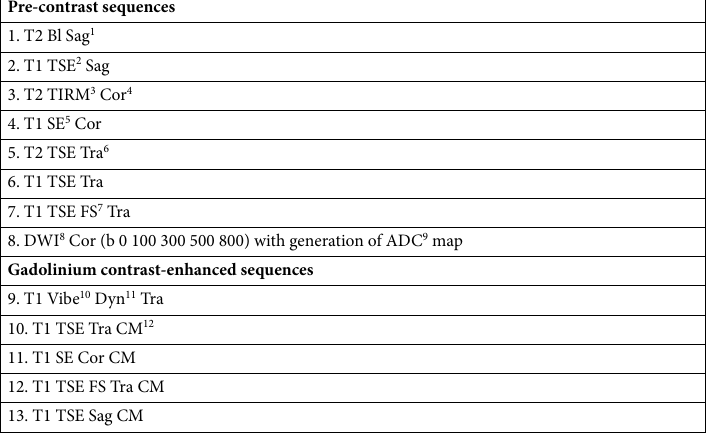
Table 1. MRI examination protocol. 1 Sag, sagittal; 2 TSE, Turbo Spin Echo; 3 TIRM, Turbo Inversion Recovery Magnitude; 4 Cor, coronal; 5 SE, Spin Echo; 6 Tra, transverse; 7 FS, Fat saturation; 8 DWI, diffusion weighted imaging; 9 ADC, apparent diffusion coefficient; 10 Vibe, volumetric interpolated breath-hold examination; 11 dyn, dynamic imaging post intravenous contrast agent administration; 12 CM, contrast